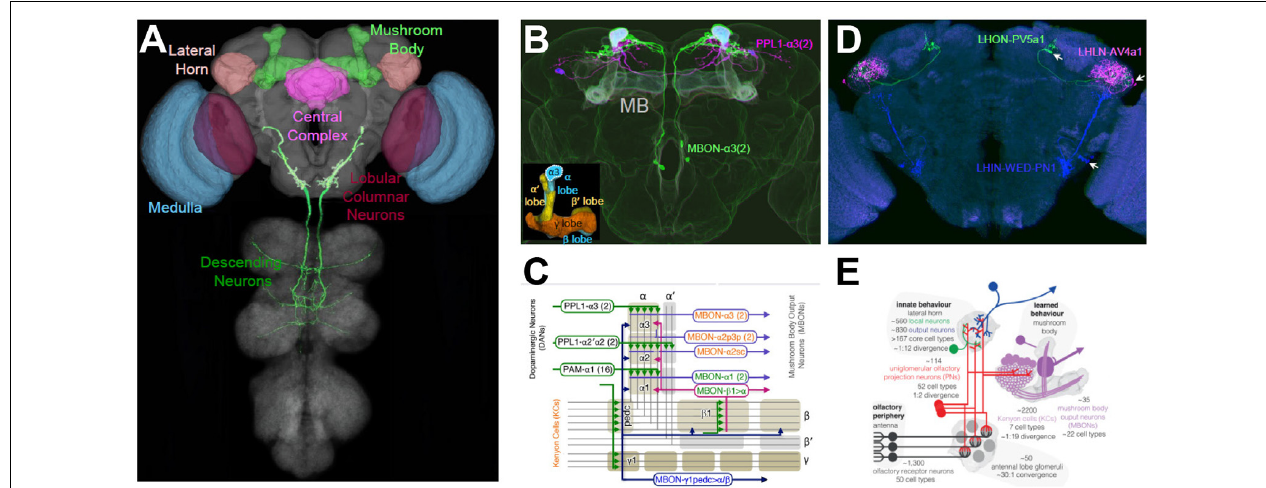
FIGURE 5 | Targeting cell types of anatomical interest. (A) Colored regions indicate structures within the Drosophila CNS for which comprehensive libraries of cell type-specific Split Gal4 drivers have been made. Targeted cell types include those of the medulla (blue) and lobula (red) in the optic lobes. In the central brain, cell types of the mushroom body (MB; light green), lateral horn (LH; light brown), and parts of the central complex (magenta) have been targeted. Also, over 100 Split Gal4 drivers have been made that target diverse neuron types that send descending projections from the brain into the ventral nerve cord (dark green). See text and Table 1 for references and details. (B) Examples of Split Gal4 drivers that target MB neurons. One driver, PPL1- α 3(2), labels two dopaminergic input neurons (magenta) with axonal projections to the α -lobe. The MBON- α 3(2) driver labels two output neurons (green) with dendritic fields in the α -lobe. The overlapping expression appears light blue and MB lobes are shaded lightly in white. Inset: the five lobes of the MB formed by Kenyon Cell axons. α , α ’ lobes, vertical blue and yellow, respectively; β , β ’ lobes, horizontal blue and yellow, respectively; γ lobe, orange. The α 3 compartments of the α -lobe, which is targeted by both the PPL1- α 3 and MBON- α 3 processes are outlined. (C) The topology of MB circuits deduced from the anatomical analysis of the MB Split Gal4 drivers. The axons of the Kenyon Cells (gray lines) form the lobes of the MB, which divides into 16 compartments (rounded rectangles). Each compartment is characterized by its